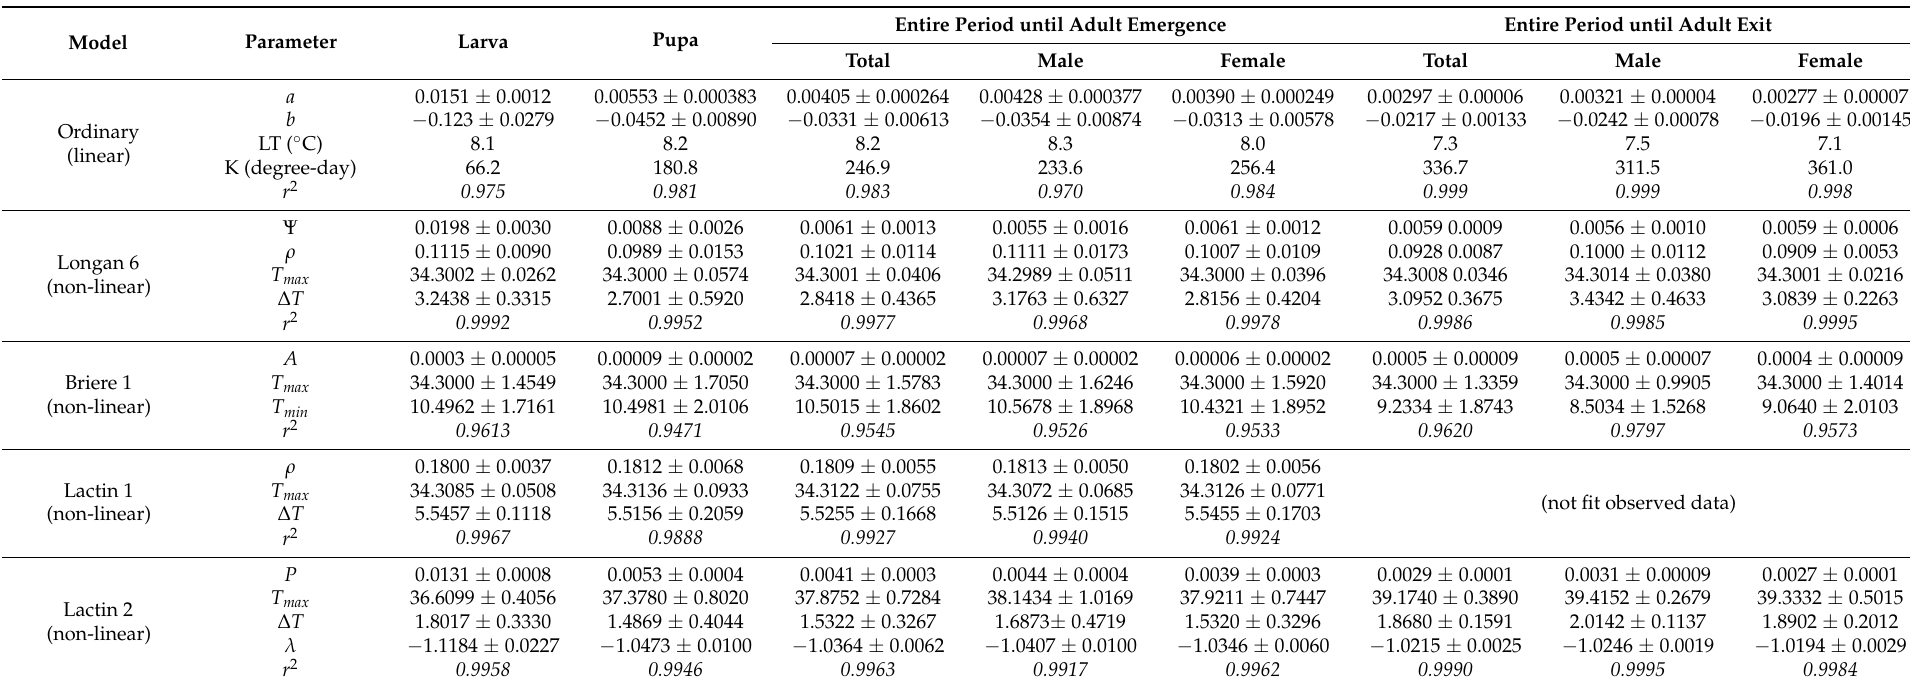
Table A2. Parameters estimate for models describing the temperature-dependent development of the post-diapause periods of Eurytoma maslovskii from overwintered larva until adult emergence and adult exit from their hosted apricot seeds based on linear regression and non-linear